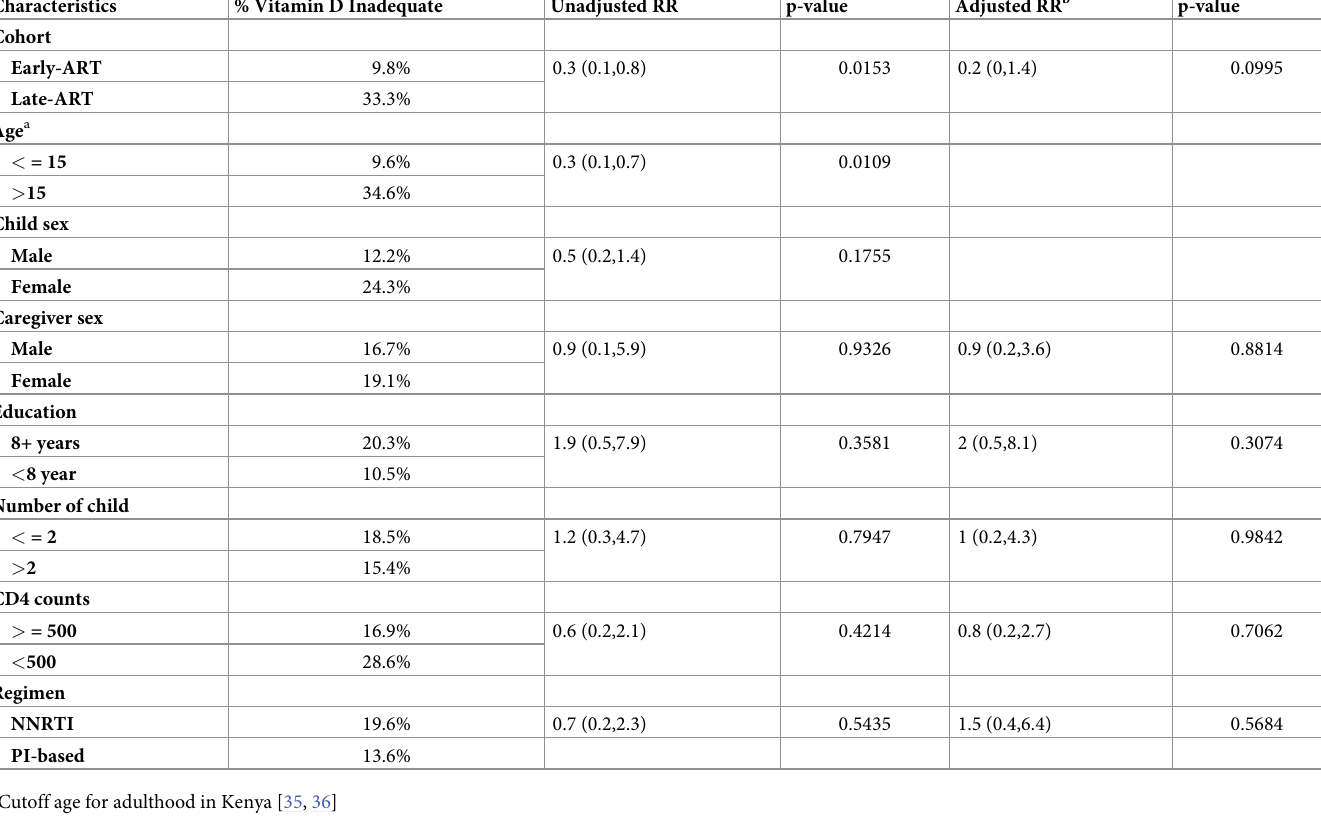
Table 3. Association between vitamin D status (inadequate) and characteristics of Kenyan children on long-term ART (Risk Ratio (RR) and 95% confidence inter- vals (CI), both unadjusted and adjusted by age and sex).